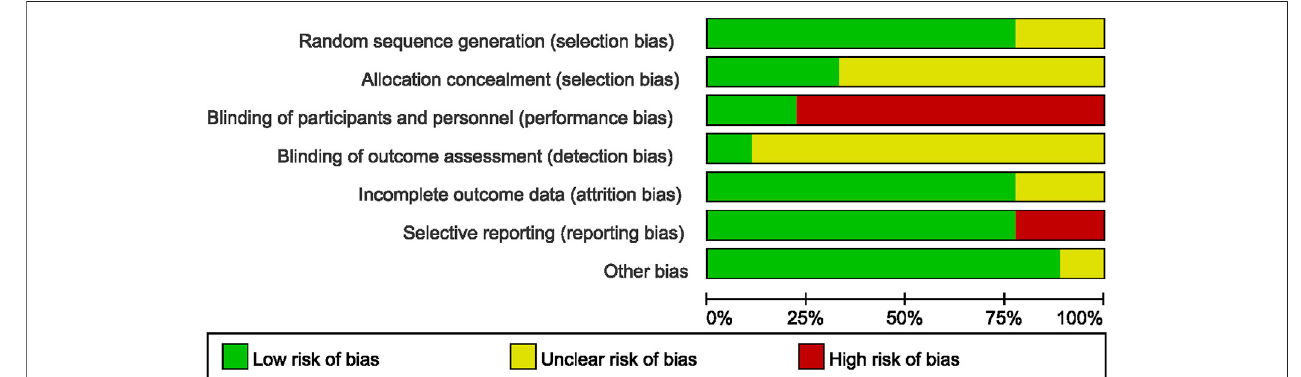
FIGURE 2 | Risk of bias graph.